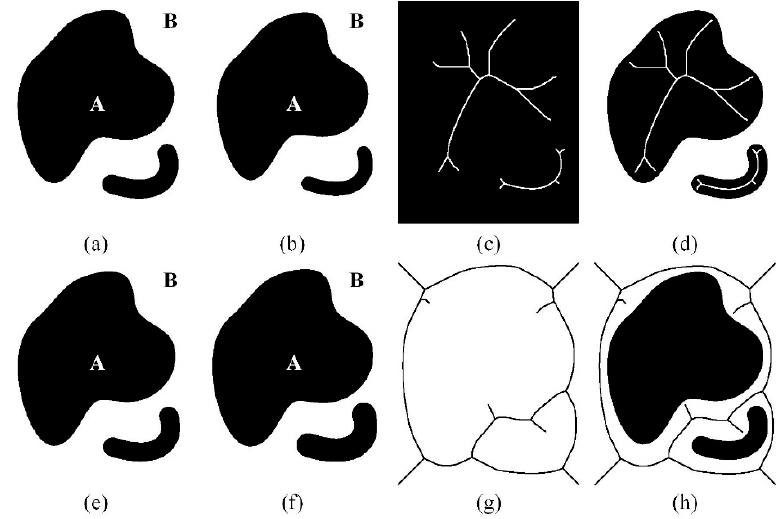
Figure 4. The process of marking the shadowed/non-shadowed areas with erosion and skeleton operations: ( a ) original shadowed area A; ( b ) shadowed area A after the erosion operation; ( c ) white marks of shadowed area A after the skeleton operation; ( d ) superimposed marks of the shaded area on the original shadowed result; ( e ) original non-shadowed area B; ( f ) non-shadowed area B after the erosion operation; ( g ) black marks of non-shadowed area B after the skeleton operation; and ( h ) superimposed marks of the lit area on the original non-shadowed result.